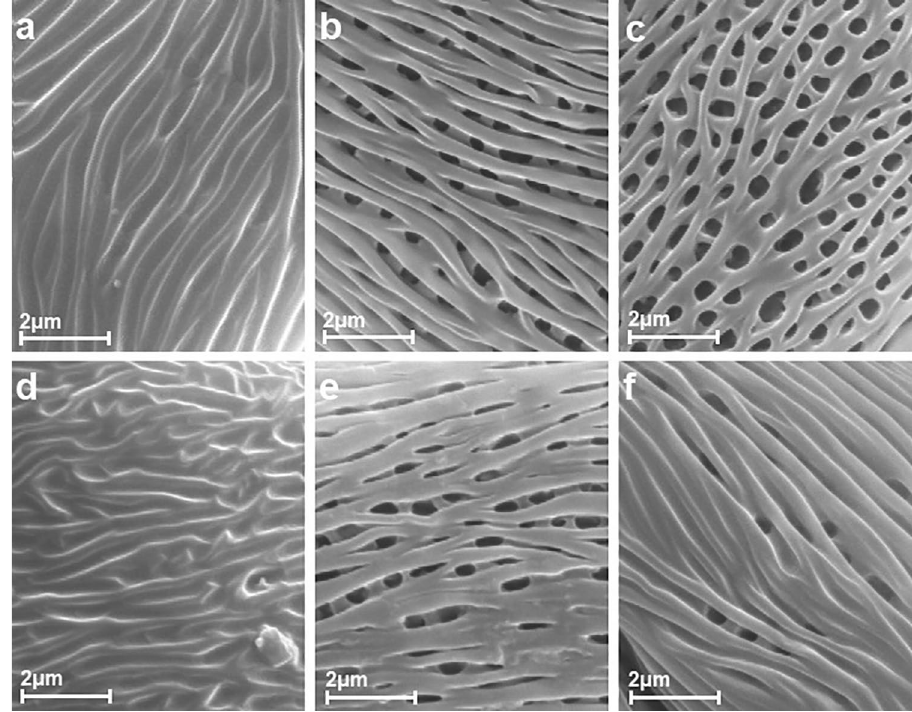
Figure 3. Striate exine ornamentation types of P. serotina after application of various herbicides (( a ) – Chikara, ( b ) – Chwastox, ( c ) – Logo, ( d ) – Mustang, ( e ) – Roundup, ( f ) – Control).